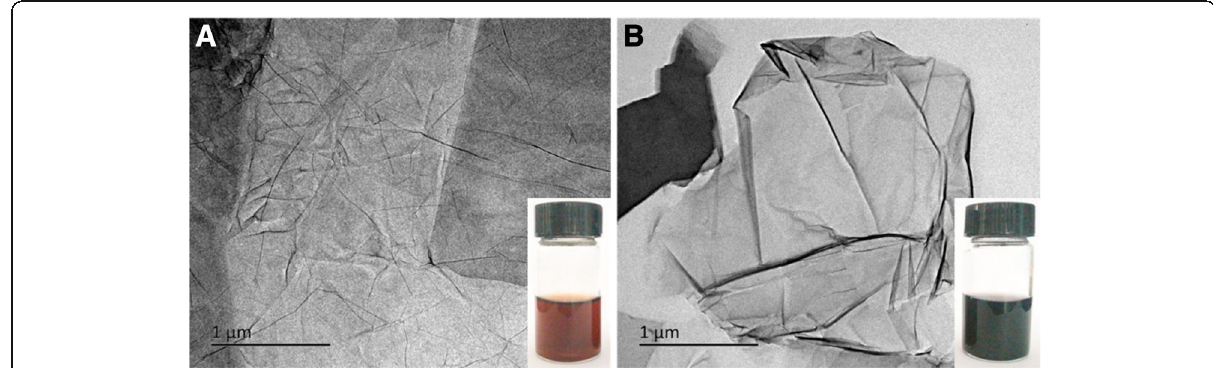
Fig. 2 TEM images of GO ( a ) and NrGO ( b ). The inset picture is optical photograph corresponding sample dispersion with concentration of 1